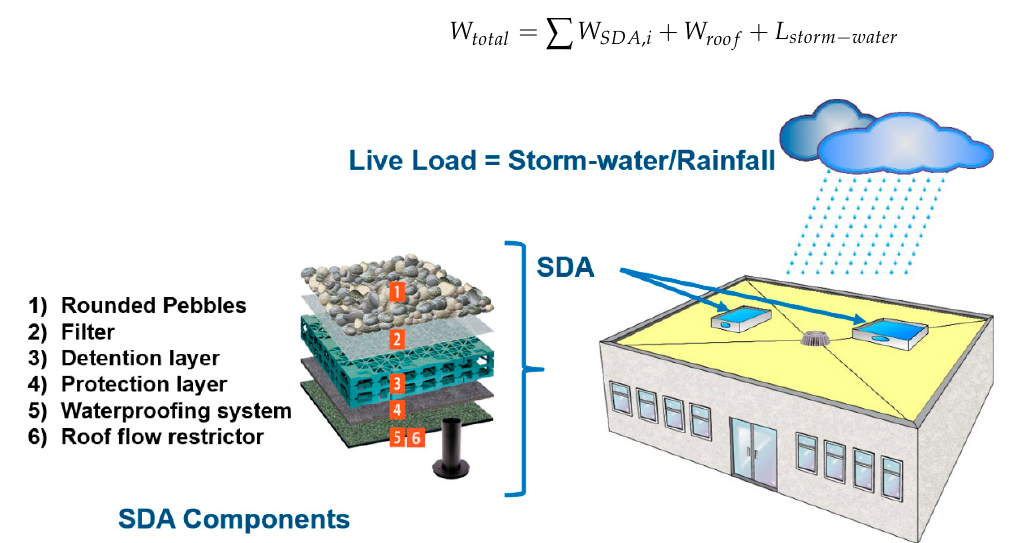
Figure 5. Image of imposed (dead) load and rainfall (live) load on the roofing assembly.